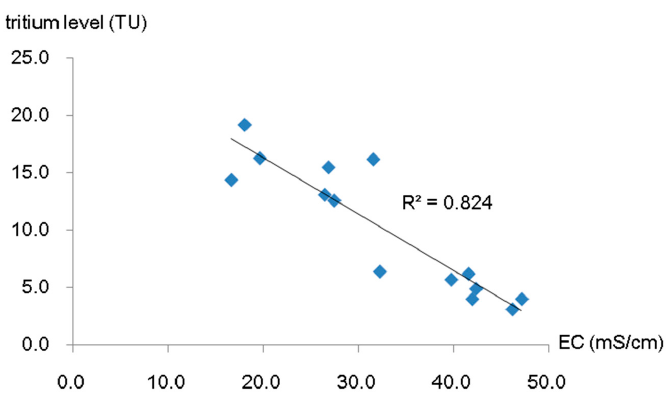
Figure 8. Hydrogeological section of the storage layers (line A-A’ in Figure 3).